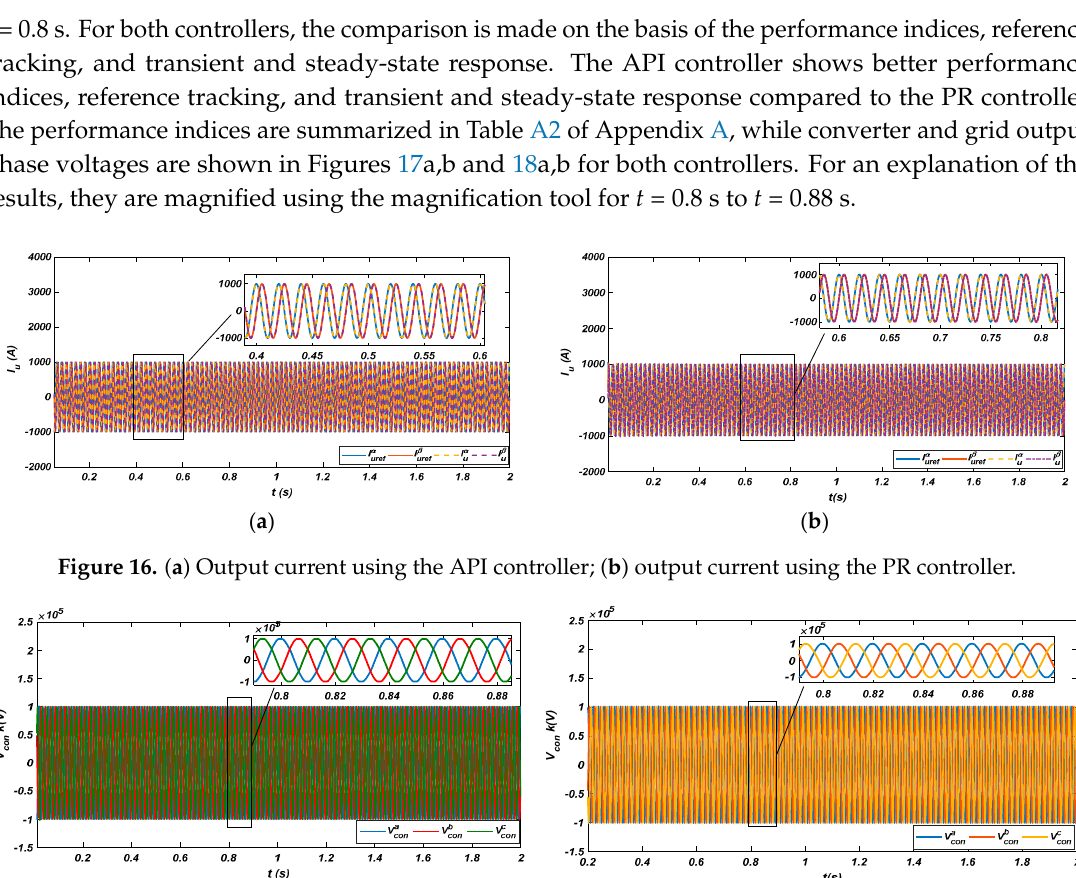
Figure 15. ( a ) Energy difference of arms using the API controller; (b) energy difference of arms using the PR controller.